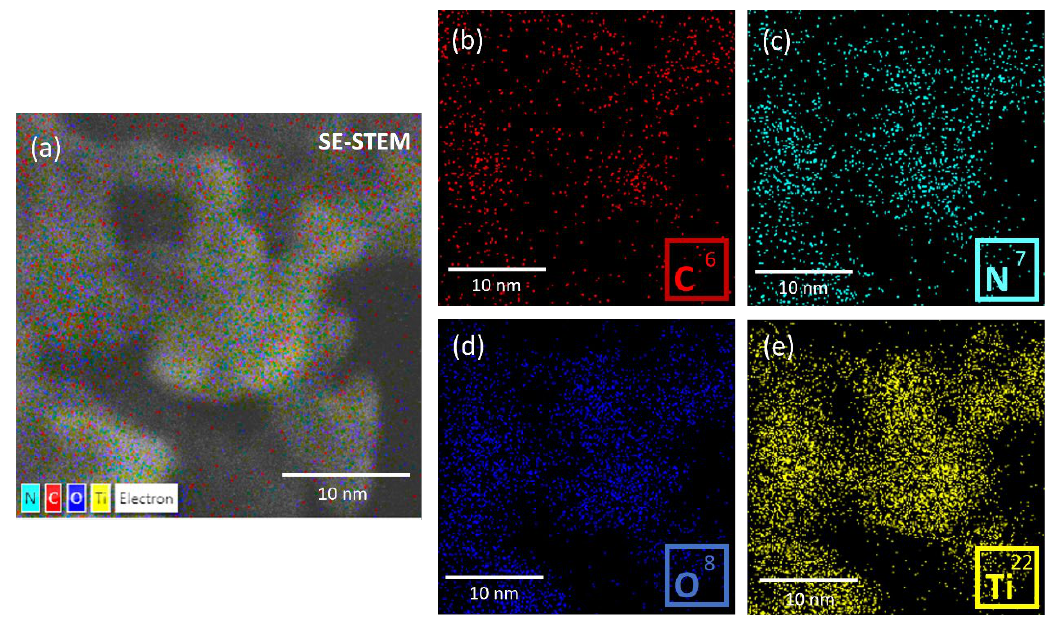
Figure 6 . Artificially colored (mixed) SE-STEM image of the 30-GCN-T material ( a ), together with the corresponding EDS maps of C ( b ), N ( c ), O ( d ) and Ti ( e ).